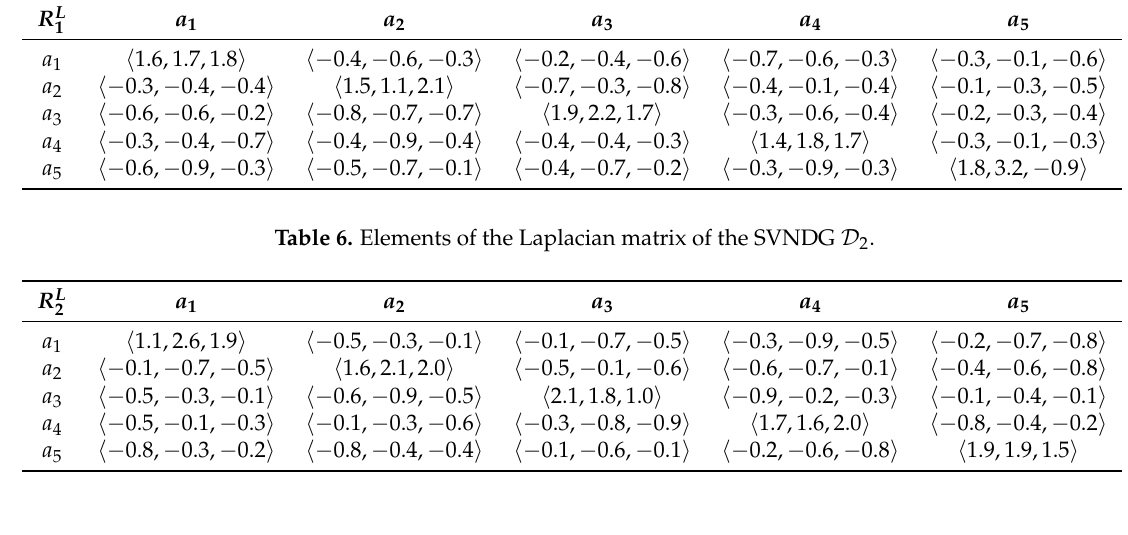
Table 5. Elements of the Laplacian matrix of the SVNDG